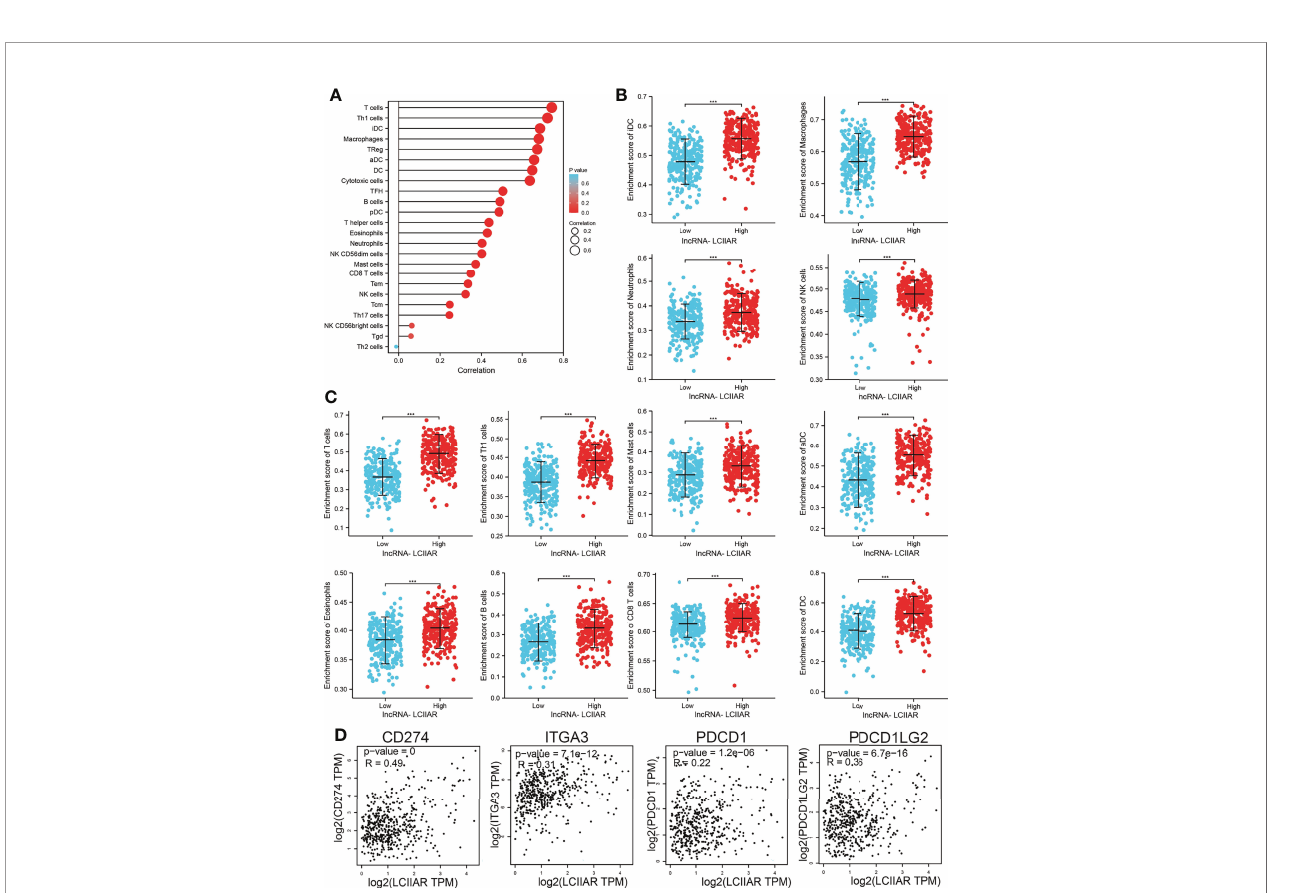
FIGURE 6 | GSEA enrichment of LCIIAR (A, B) GSEA enrichment analysis of the potential signaling pathway of LCIIAR high and low expression group gene in LUAD.